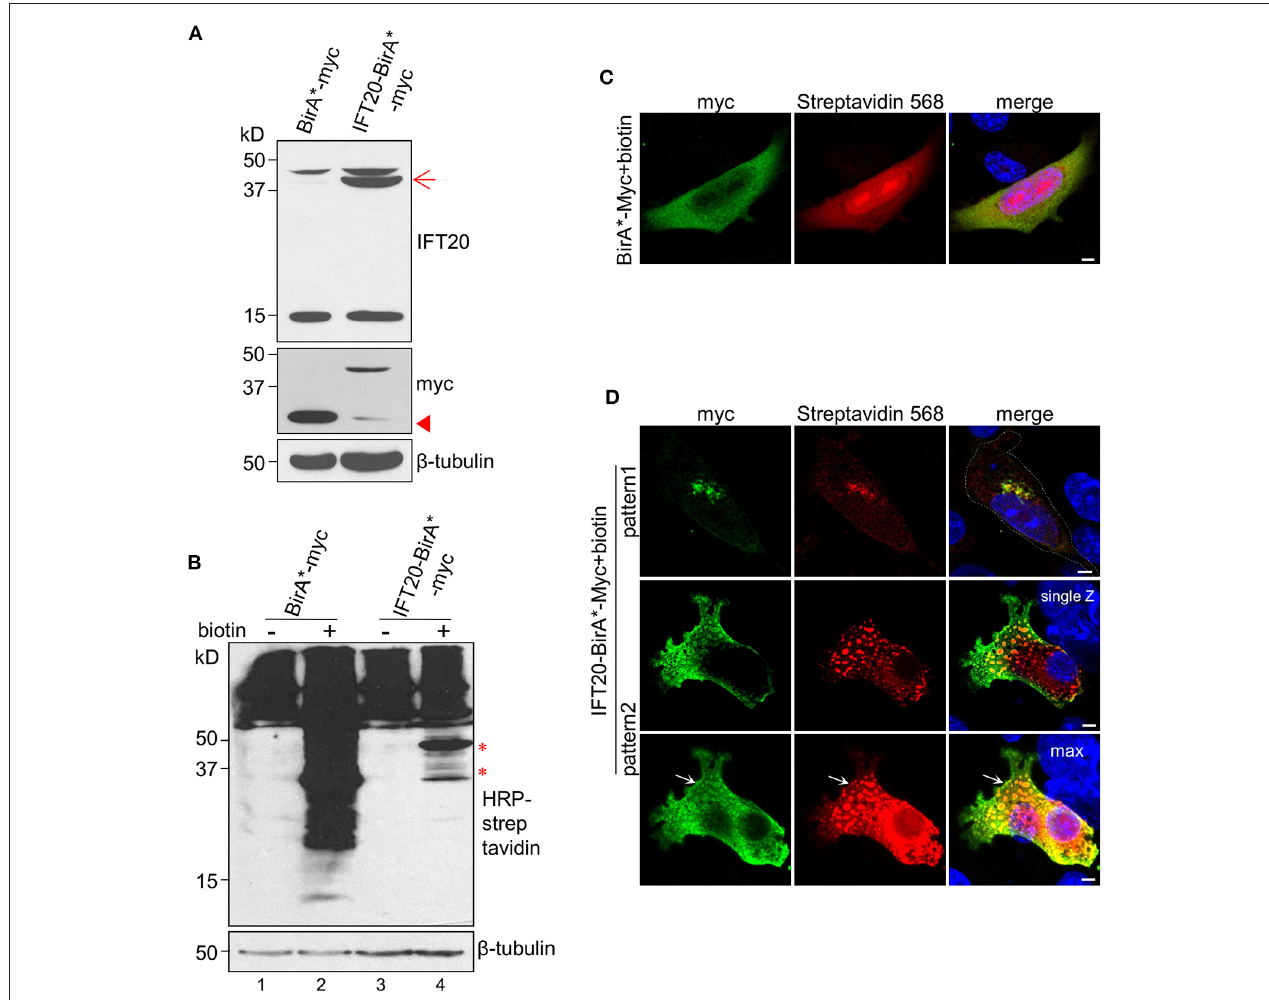
FIGURE 6 | Identification of IFT20 interactors using the BioID method. (A) Western blots from lysates of 4T1 cells expressing IFT20-BirA*-Myc or BirA*-Myc probed with IFT20 and Myc antibodies. The arrow points to the anticipated band of IFT20-BirA*-Myc. The arrowhead points to the band of slight truncation of IFT20-BirA*-Myc. (B) Western blots from lysates of 4T1 cells expressing IFT20-BirA*-Myc or BirA*-Myc probed with HRP-streptavidin with/without biotin addition; the results showed that the amount of biotinylated proteins increased when biotin was added. The asterisks indicate the specified bands with IFT20-BirA*-Myc in the presence of biotin. The numbers below represent different columns. (C) Representative immunofluorescence of 4T1 cells expressing BirA*-Myc in the presence of biotin probed with Myc antibodies to show the cytosol localization of BirA*-Myc and probed with streptavidin 568 to show the biotinylated proteins. (D) Representative immunofluorescence images of 4T1 expressing IFT20-BirA*-Myc in the presence of biotin probed with Myc antibodies to show the localization of fusion proteins and probed with streptavidin 568 to show the localization of biotinylated proteins. The top panels show the Golgi localization, while the lower two panels (representing the single Z-stack and max projection with five Z-stacks) show the vesicle-like localization of IFT20-BirA*-Myc and biotinylated proteins. The white dotted lines mark the entire cell profile. The white arrows indicate the vesicle-like distribution near the plasma membrane of IFT20-BirA*-Myc. The z-axis series of optical sections were performed at 0.8 µ m-thick sections. The β -tubulin was used as the loading control in the Western blots. All immunostaining experiments were performed two times. The nucleus is stained by DAPI (blue); scale bar, 5 µ